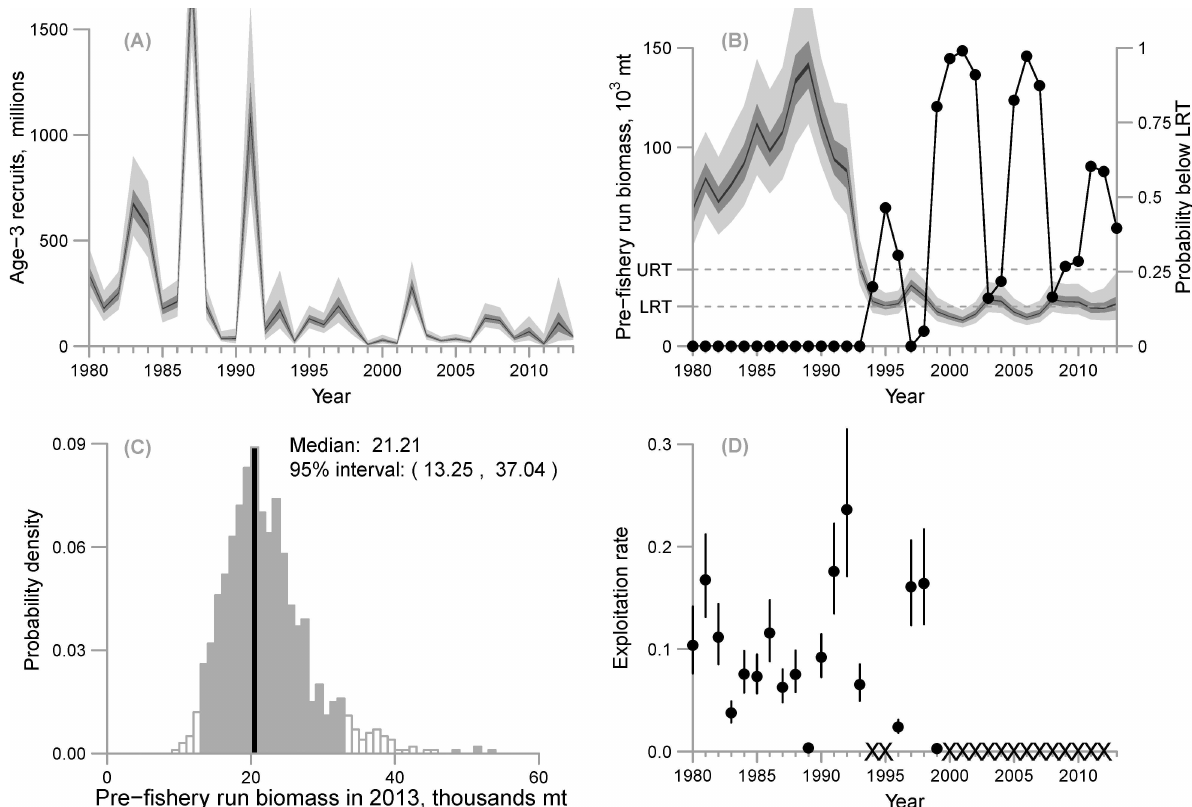
Fig 10. Results from the sensitivity analysis using the fixed value of 0.35 yr-1 for background natural mortality. See Fig 7 caption for explanation of panels,colors, and